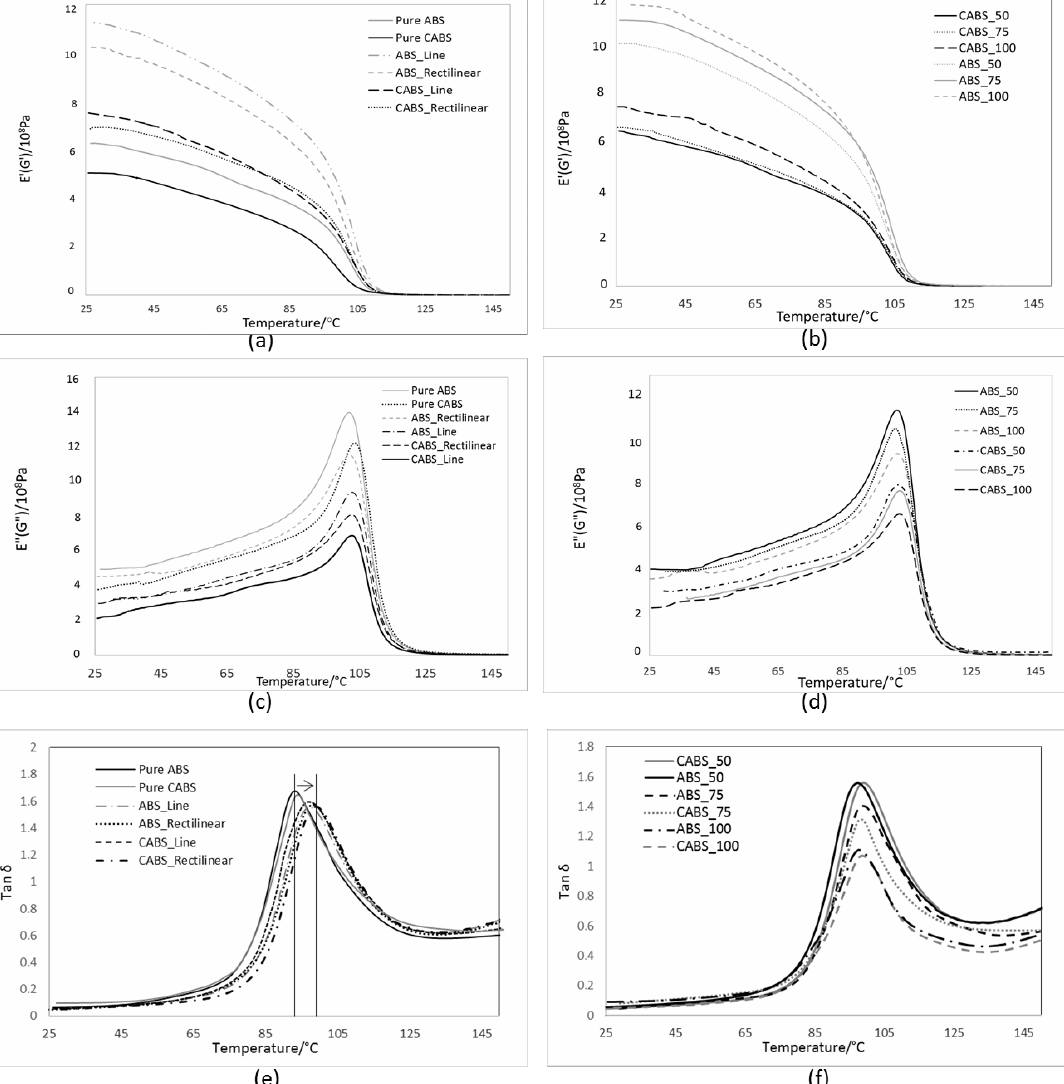
Figure 8. Effect of infill density and printing pattern on dynamic mechanical properties. ( a , b ) Storage modulus (E ’ ), ( c , d ) loss modulus (E ’’ ), and ( e , f ) damping factor.